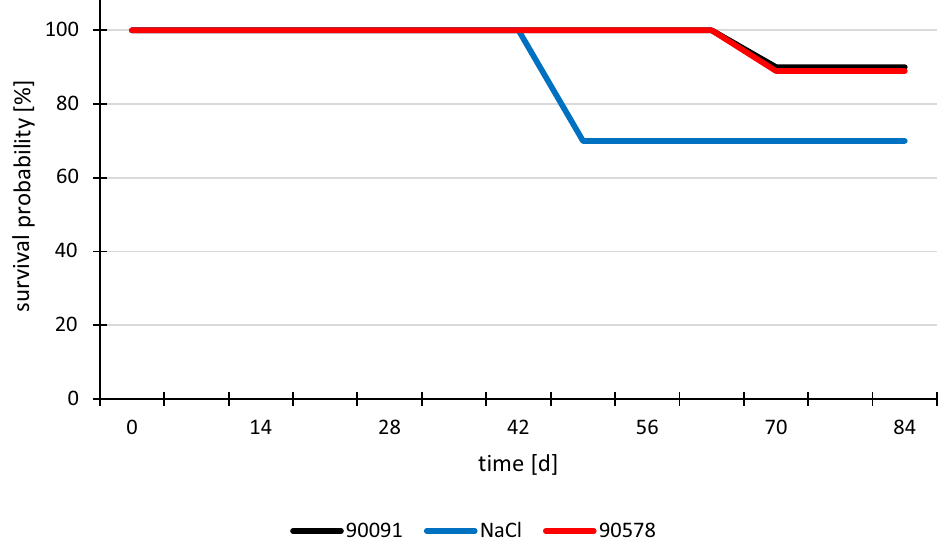
Figure 6. Kaplan–Meier-Chart of the survival probability in different treatment groups Mice were killed prior to the end of experiment when arthritis was too severe. Treatments: red: peptide 90578; black: peptide 90091; blue: